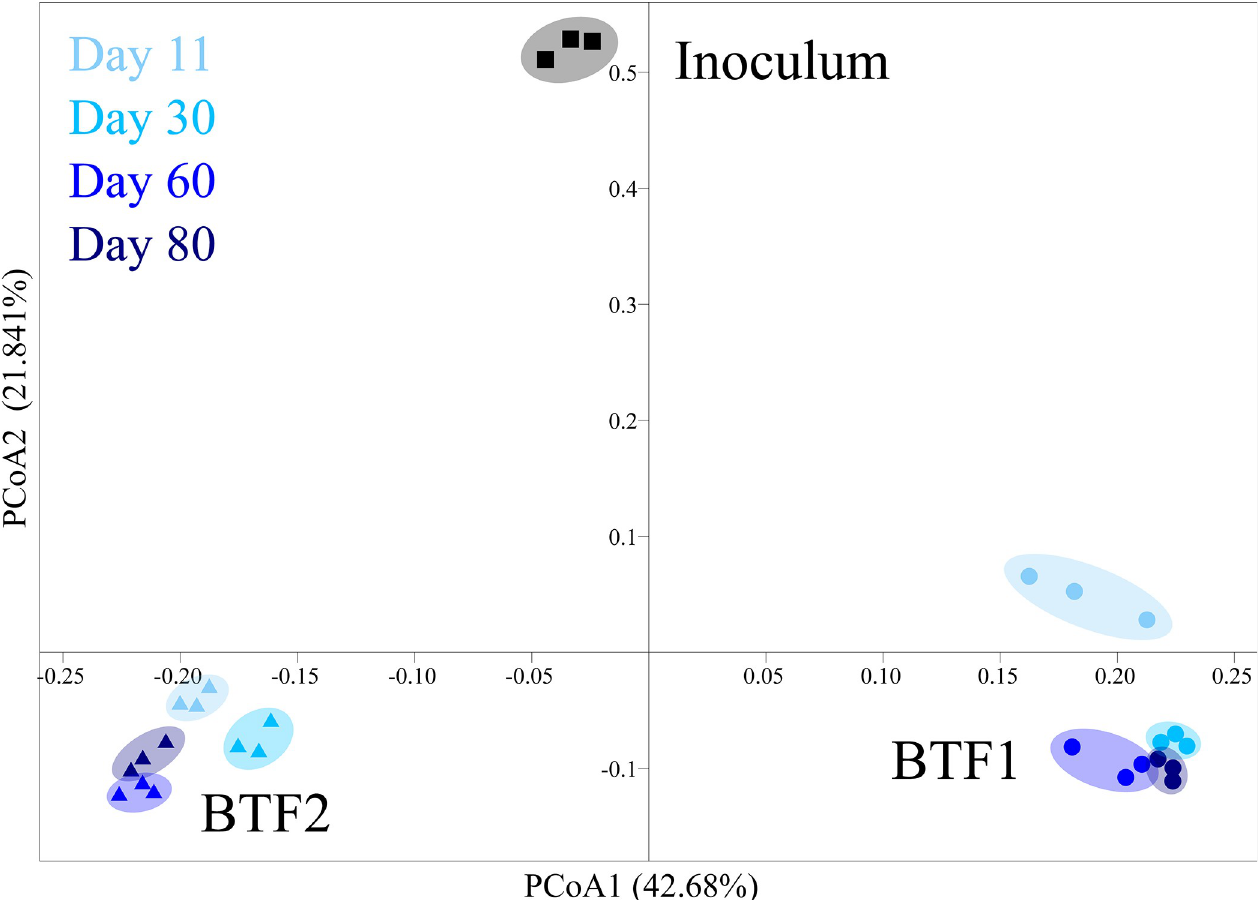
Fig 4. Weighted principal coordinate analysis (PCoA) of microbial communities. Sample from initial inoculums are showed with squares. Sample from BTF1 are showed with circles. Sample from BTF2 are showed with triangles.